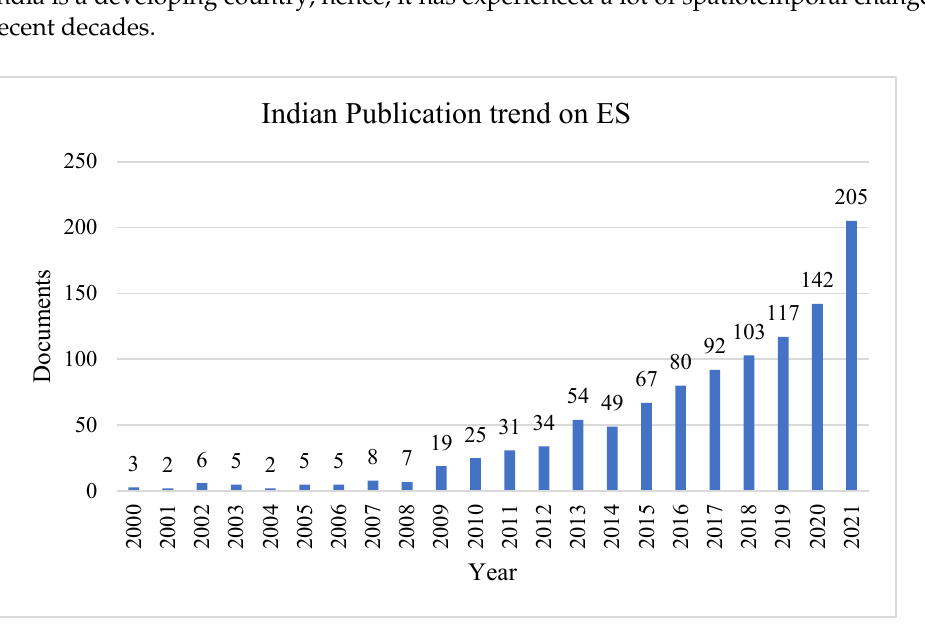
Figure 8. Indian Ecosystem service Publication trends. Table 2. Studies conducted on ESs in India .